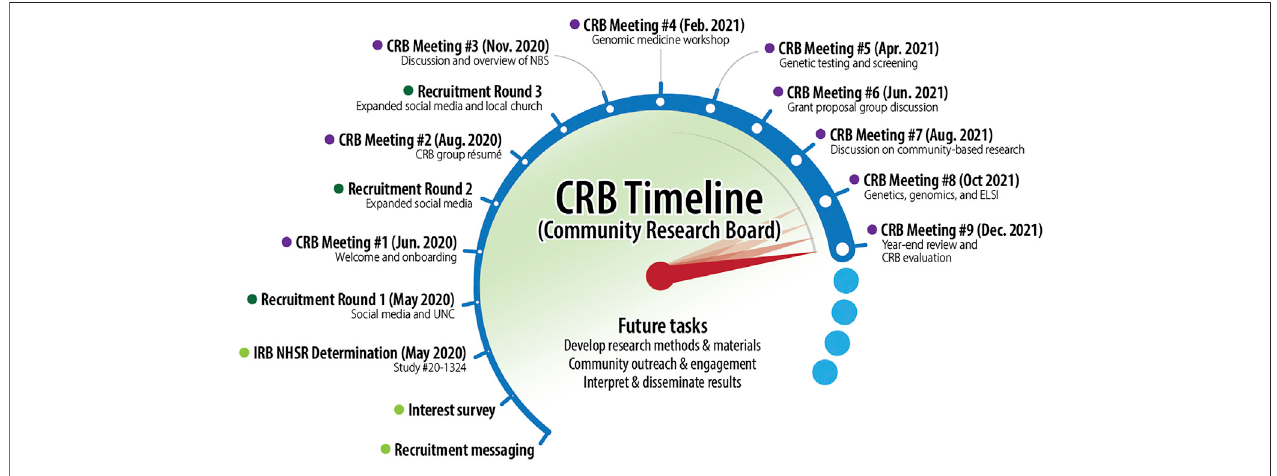
FIGURE 2 | Timeline of CRB establishment and activities in 2020 and